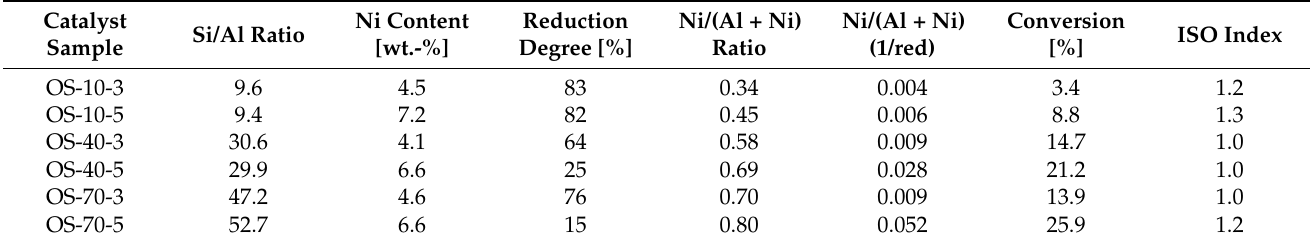
Table 1. Characterization and catalytic data of the synthesized